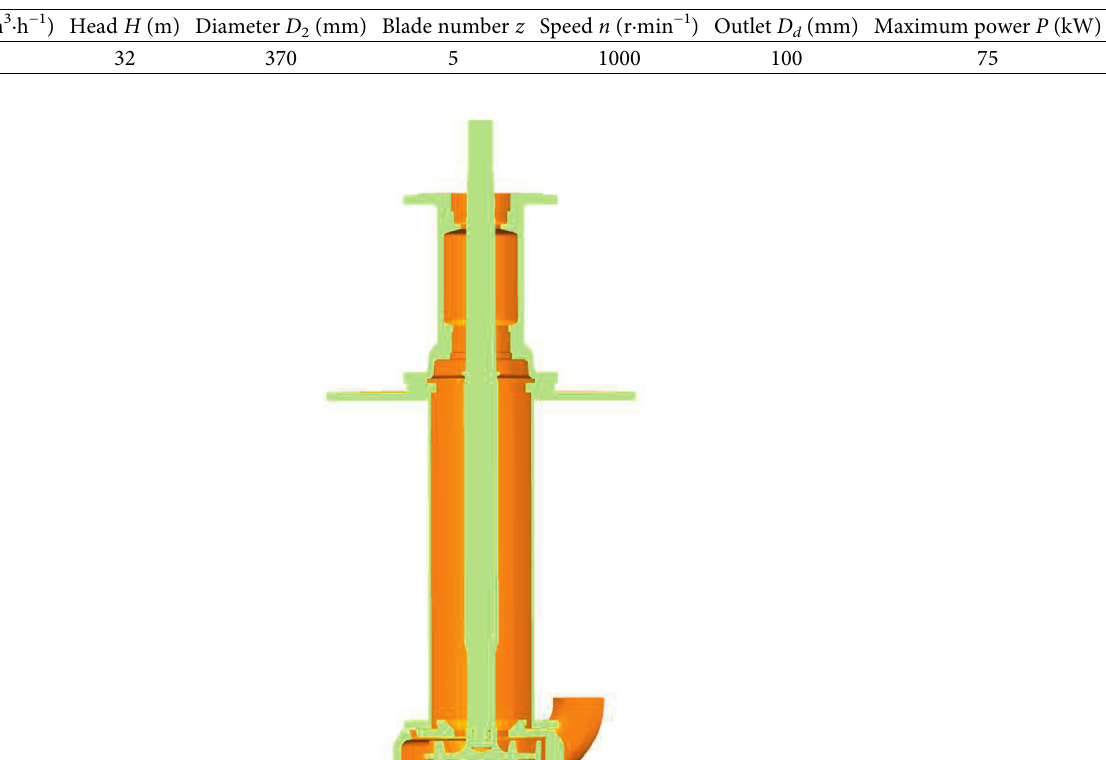
Figure 1: Solid model of sump pump rotor. Table 1: Sump pump design